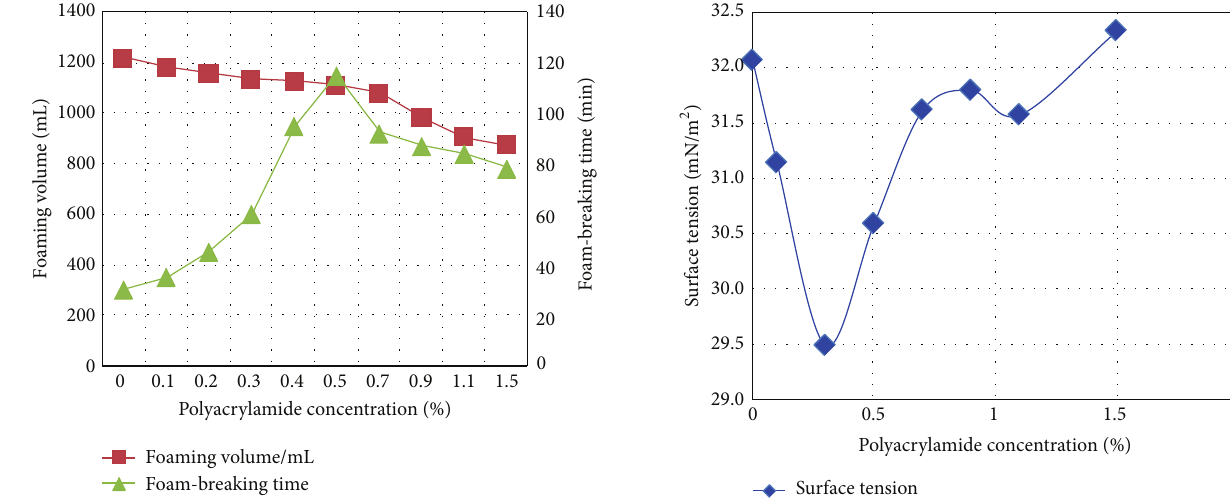
Figure 7: The change of surface tension with polyacrylamide.